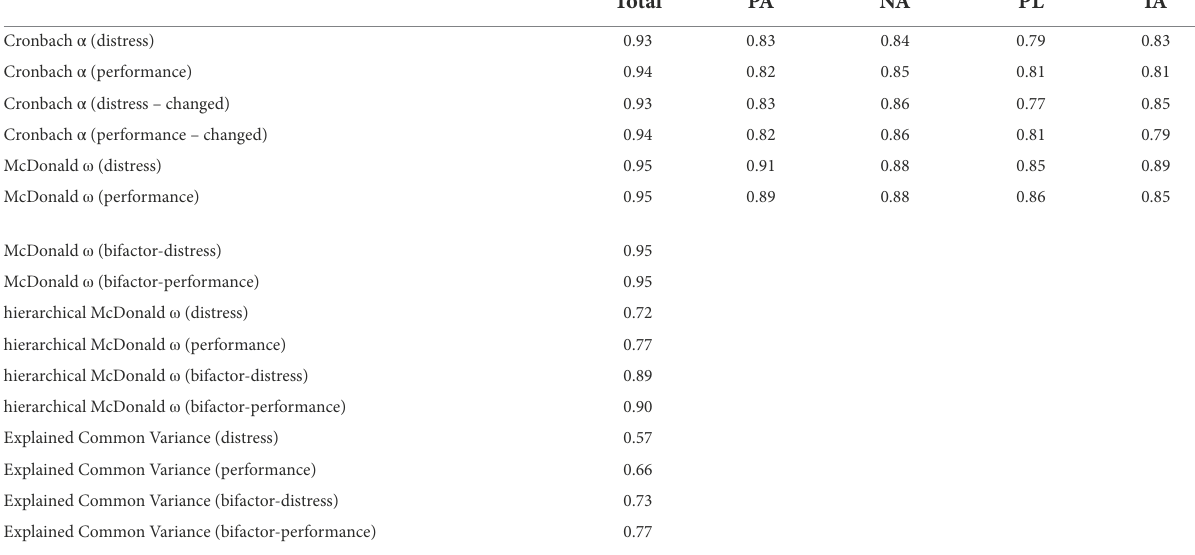
TABLE 1 s-SIB – reliability values and explained common